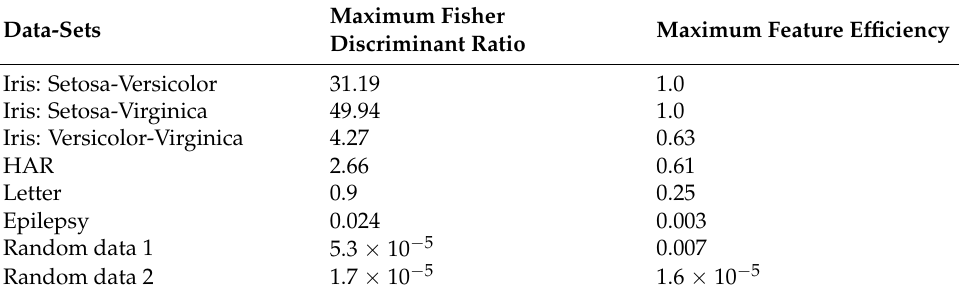
Table 3. Comparison of the maximum Fisher discriminant ratio and the maximum feature efficiency for various classification problems: (1) Iris: Versicolor-Virginica, (2) Iris: Setosa-Virginica, (3) Iris: Setosa-Versicolor, (4) Letter recognition, (5) epilepsy prediction, (6) human activity recognition (HAR) and couple random noise sets, (7) random data 1 and, (8) random data